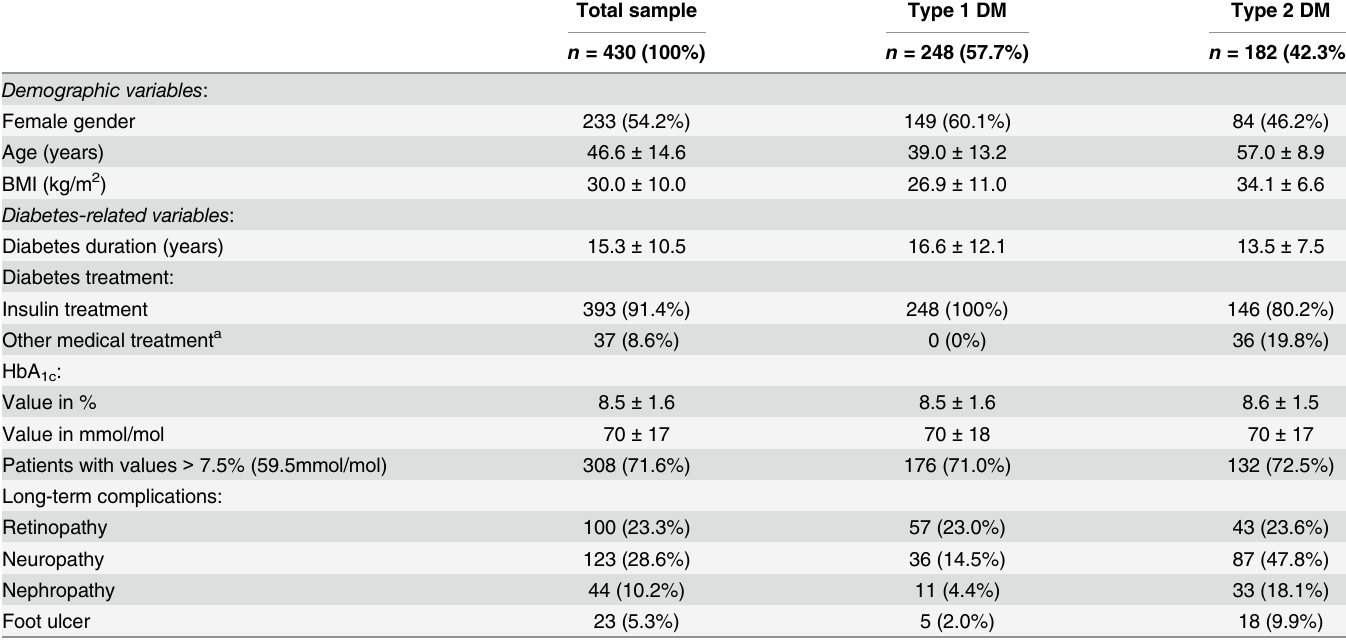
Table 1. Characteristics of the study